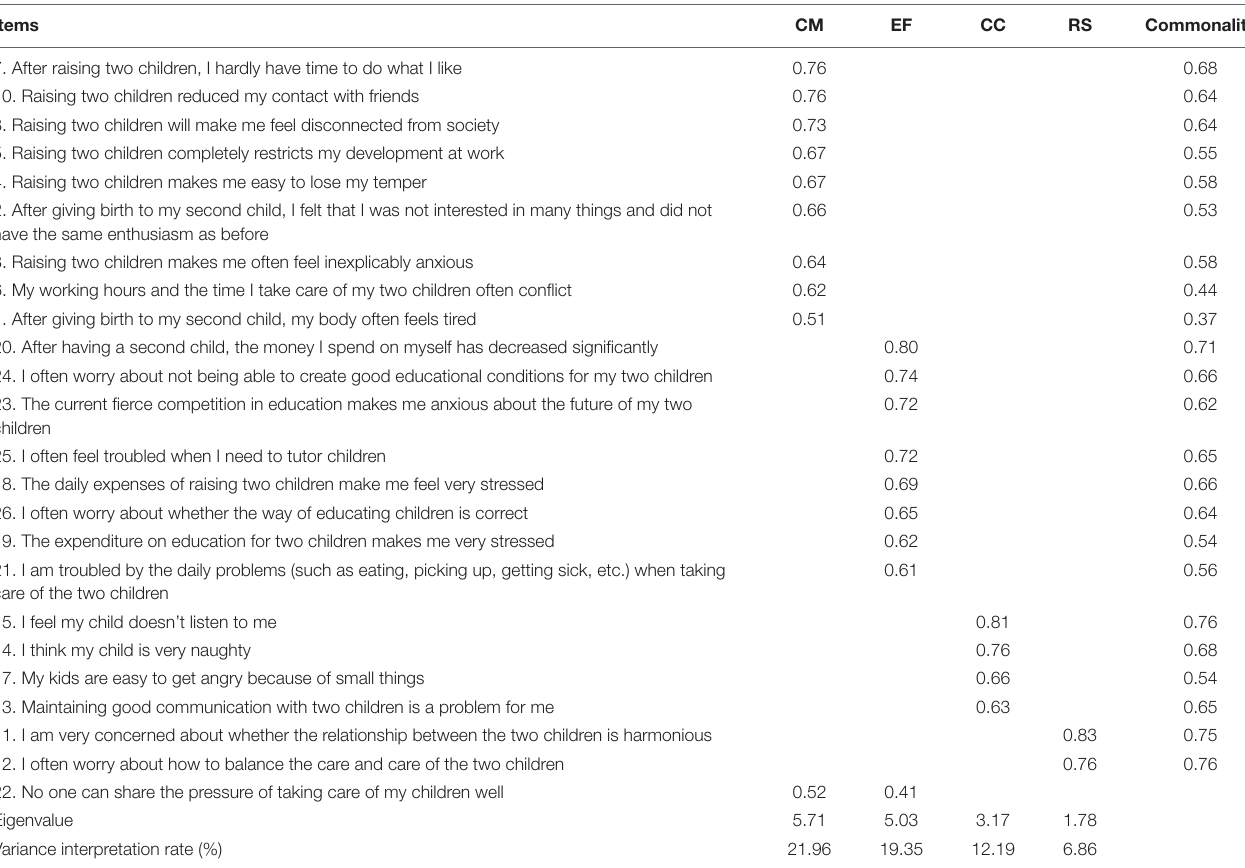
TABLE 2 | Loading parameter estimates in EFA from the four-factor solution and commonality estimates for the 26-item version of the questionnaire in subsample 1 ( n = 279). Items CM EF